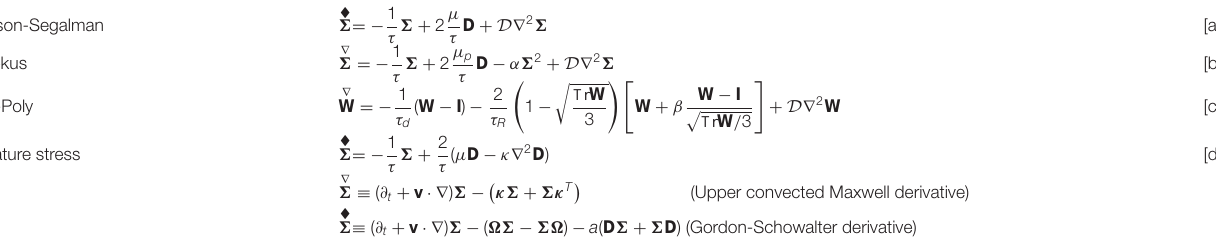
TABLE 1 | Constitutive models that exhibit shear banding for polymeric fluids with no concentration variations from Olmsted et al. [15] [a], Giesekus [25] [b], Likhtman and Graham [26] [c], Yuan et al. [27] and Dhont [28] [d].